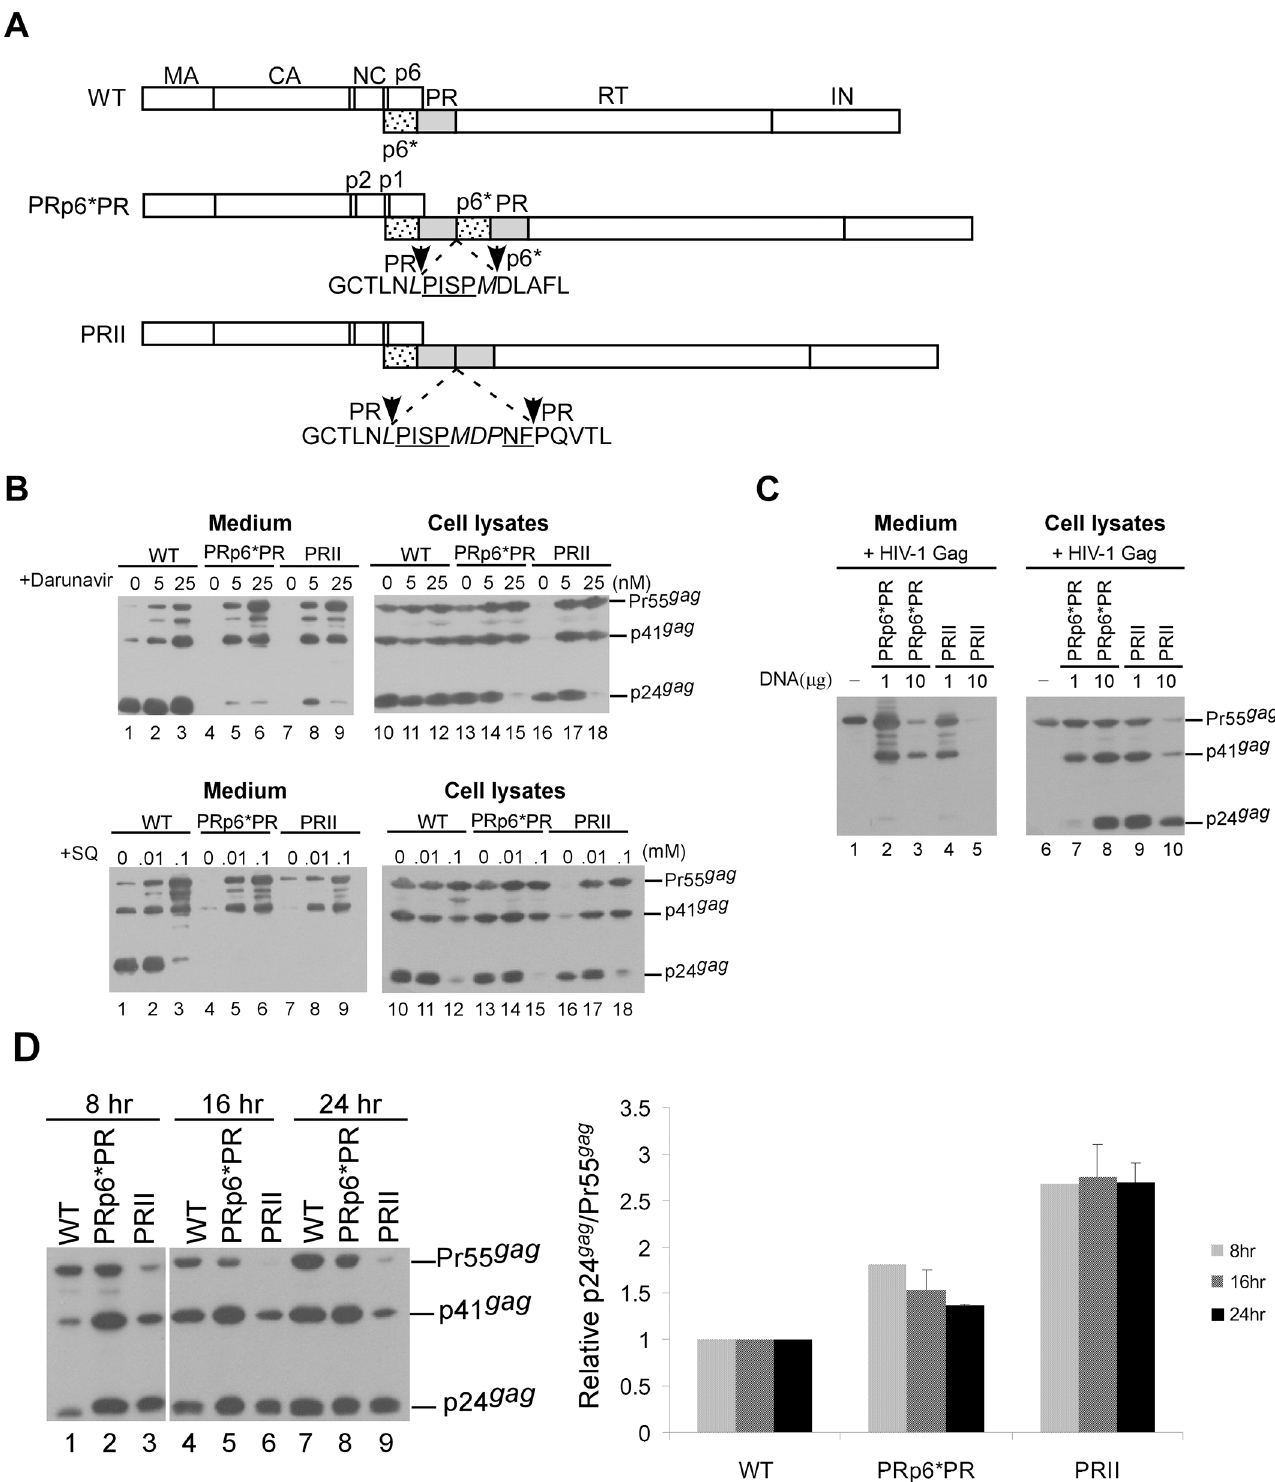
Fig 1. Assembly and processing of HIV-1 mutants containing duplicate PR or p6 * PR domains. (A) Schematic representations of wild-type (WT) and recombinant HIV-1 mutants. Indicated are the HIV-1 Gag protein domains MA (matrix), CA (capsid), NC (nucleocapsid), p6, pol -encoded p6 * , PR, RT, and IN (p31). Underlined “ PISP ” and “ NF ” indicate remaining N-terminal RT and C-terminal p6 * residues, respectively. Altered or additional residues are in italics. Note the deletion of four N-terminal residues from the second p6 * copy. (B) 293T cells were transfected with designated constructs. At 4 h post-transfection,